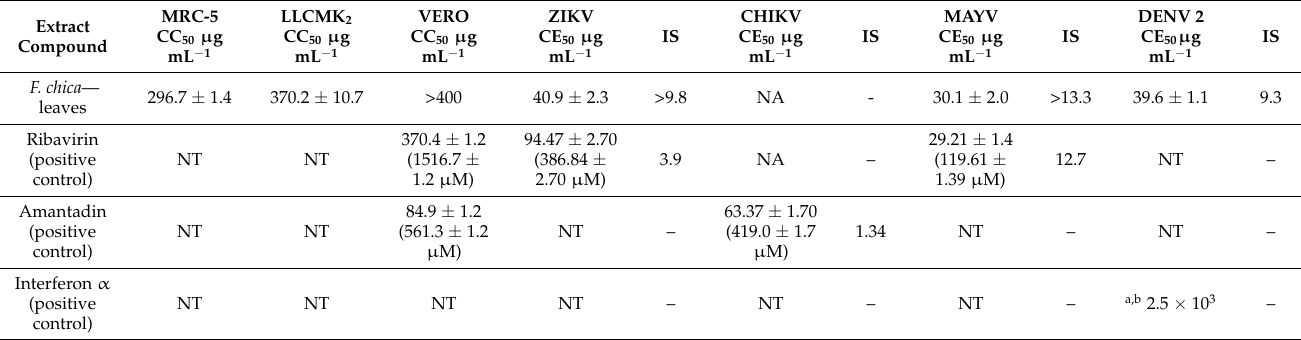
Figure 14. Dose – response curves for antiviral activity of ethanolic extract from Fridericia chica leaves against Dengue (DENV-2), Zika (ZIKV), Mayaro (MAYV) and Chikungunya (CHIKV) vi- ruses.